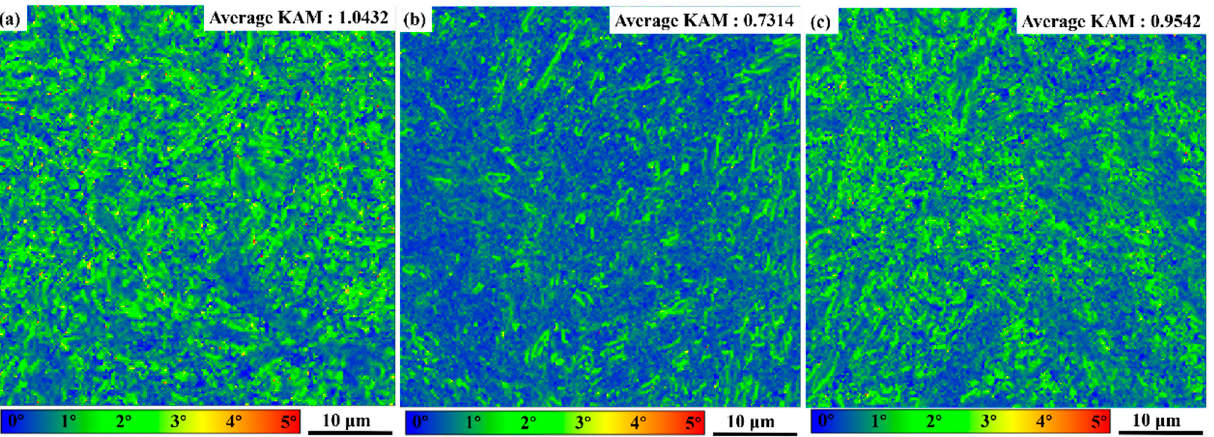
Figure 5. KAM maps of 35CrMo steel after tempering at di ff erent temperatures ( a ) 610 °C, ( b ) 680 °C, ( c ) 740 °C. ( c ) 740 ◦